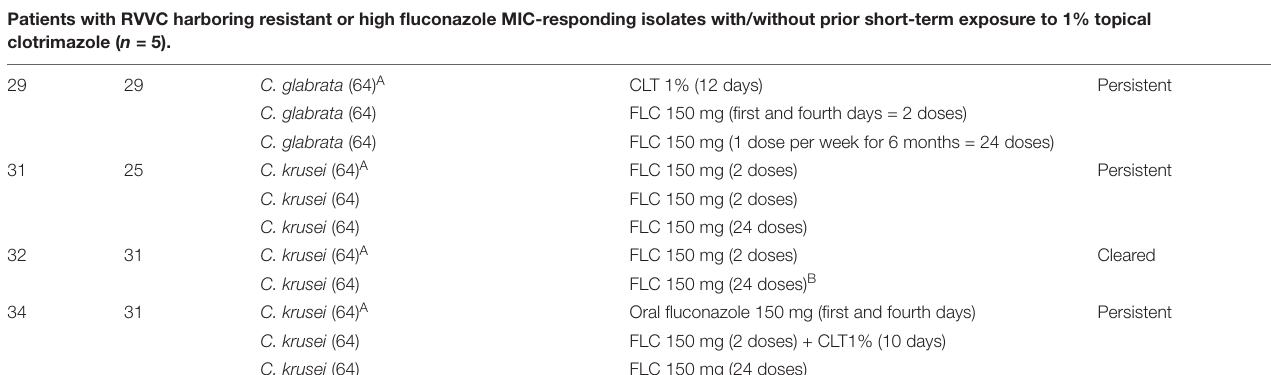
TABLE 2 | Clinical and microbiological characteristics of patients included in this study. Patient # Age (years) Species (MIC, µ g/ml)/ (isolate number) Treatment Final outcome Patients with RVVC harboring resistant or high fluconazole MIC-responding isolates with/without prior short-term exposure to 1% topical clotrimazole ( n =